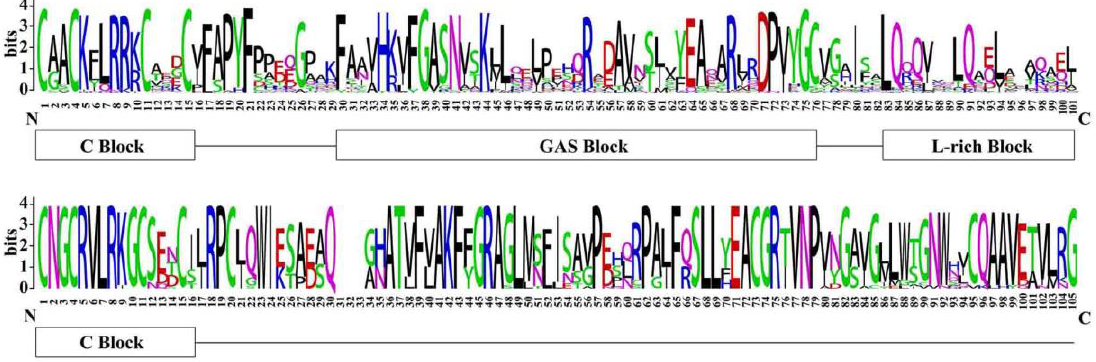
Figure 2. Sequence logos of LOB domains in BnLBD proteins. Multiple alignment analysis of LOB domains was performed with Clustal X. The sequence logos were drawn by WebLogo 3. The bit score exhibits the information content for each position in the sequence. GAS, Gly-Ala-Ser.